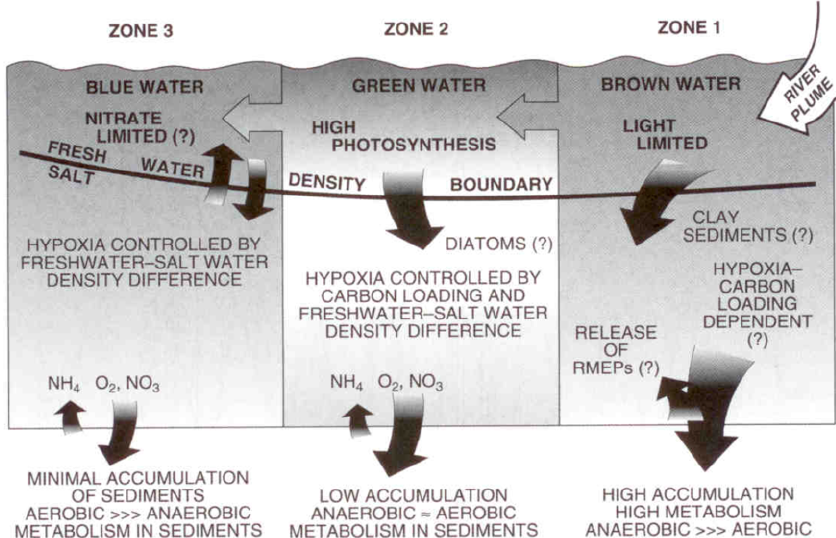
Figure 2. The Rowe and Chapman three-zone hypothesis, which describes the physical and biochemical processes that initiate and sustain hypoxia on the Louisiana–Texas shelf (Rowe and Chapman, 2002). RMEPs are reduced metabolic end products. Reprinted with permission of Gulf of Mexico Science.